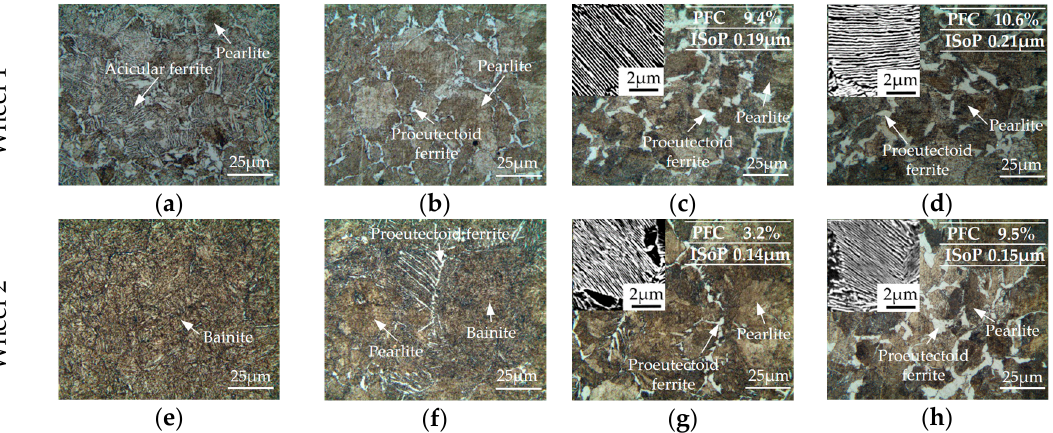
Figure 3. Microstructures of wheels: wheel 1 (standard wheel) at depths of ( a ) 2 mm, ( b ) 8 mm, ( c ) 25 mm and ( d ) 35 mm; wheel 2 (improved wheel) at depths of ( e ) 2 mm, ( f ) 8 mm, ( g ) 25 mm and ( h ) 35 mm.